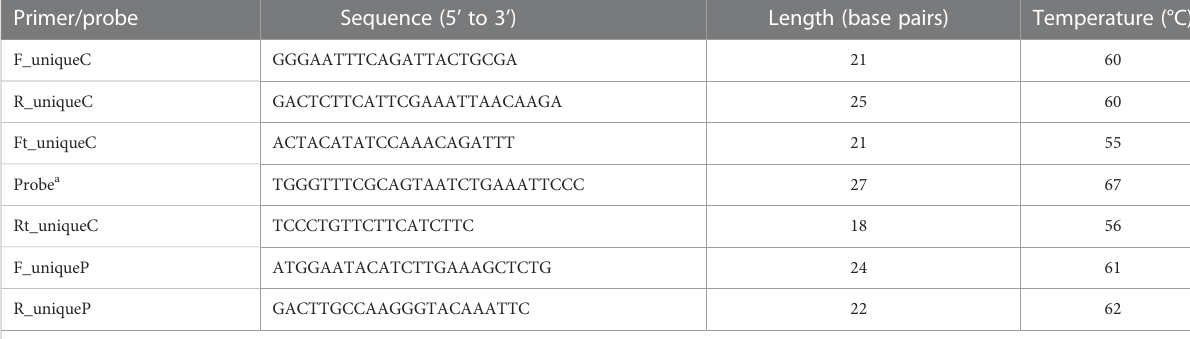
TABLE 1 Primer and probes used in the present